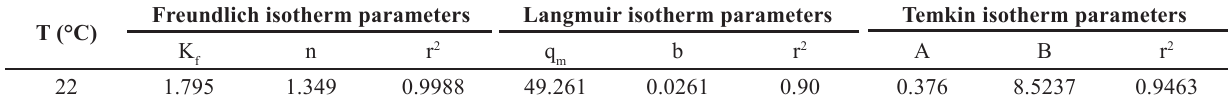
Table 3. Langmuir, Freundlich and Temkin isotherm constants for the adsorption of CV + .